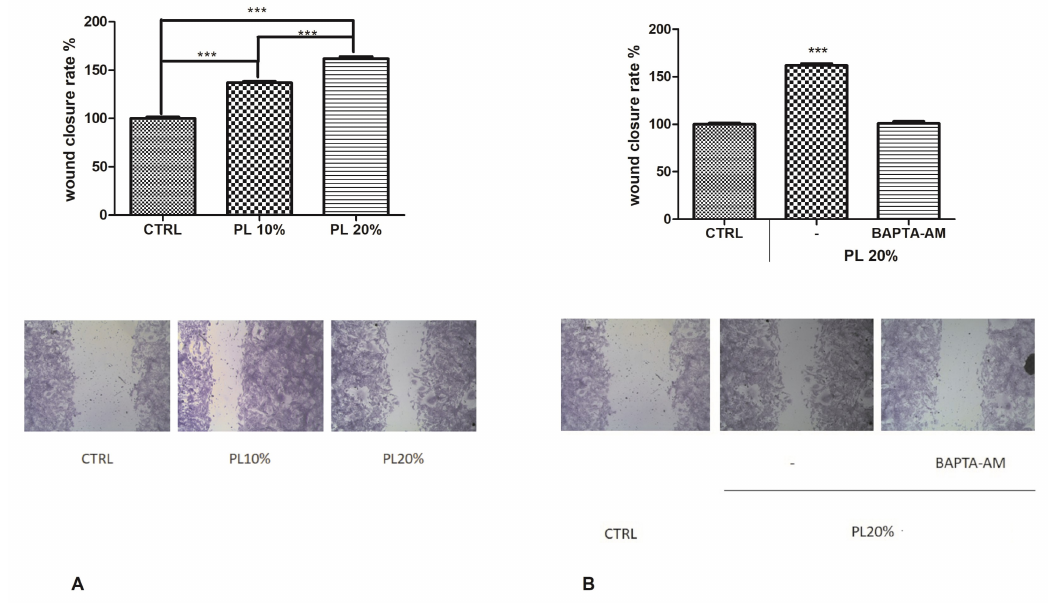
Figure 1. Platelet lysate (PL)-induced wound closure. ( A ) Upper panel: E ff ect of di ff erent concentrations of PL in scratch wound repair of bEND5 monolayers. PL was used; 10% and 20% v / v . CTRL are cells in control conditions, i.e., cells grown in DMEM with 10% FBS as described in the Materials and Methods section. Wound closure rate is expressed as the di ff erence between wound width at 0 and 24 h. Data were recorded 24 h after scratch wound healing of cells exposed to PL. Bars represent mean ± S.E.M. of wound closure derived from two independent experiments, each with n = 20. Di ff erent asterisks on bars indicate statistical di ff erences determined by one-way ANOVA with Tukey’s test ( p < 0.05). Lower panel: Micrographs of scratch-wounded bEND5 monolayers incubated under control conditions (cells incubated in DMEM with 10% FBS) or in the presence of 10% and 20% PL and then stained with blue toluidine and observed 24 h after wounding. ( B ) Upper panel: Role of intracellular Ca 2 + in PL-induced scratch wound repair of endothelial monolayers, in presence or not of 30 µ M BAPTA-AM. Wound closure rate is expressed as the di ff erence between wound width at 0 and 24 h. Data were recorded 24 h after scratch wound healing of cells exposed to PL. Bars represent mean ± S.E.M. of wound closure inhibition deriving from two independent experiments, each with n = 20. Asterisks on bars indicate statistical di ff erences determined by one-way ANOVA with Tukey’s test ( p < 0.001). Lower panel: Micrographs of scratch-wounded bEND5 monolayers incubated under control conditions (as described above) or in the presence of PL and BAPTA-AM and then stained with blue toluidine and observed 24 h after